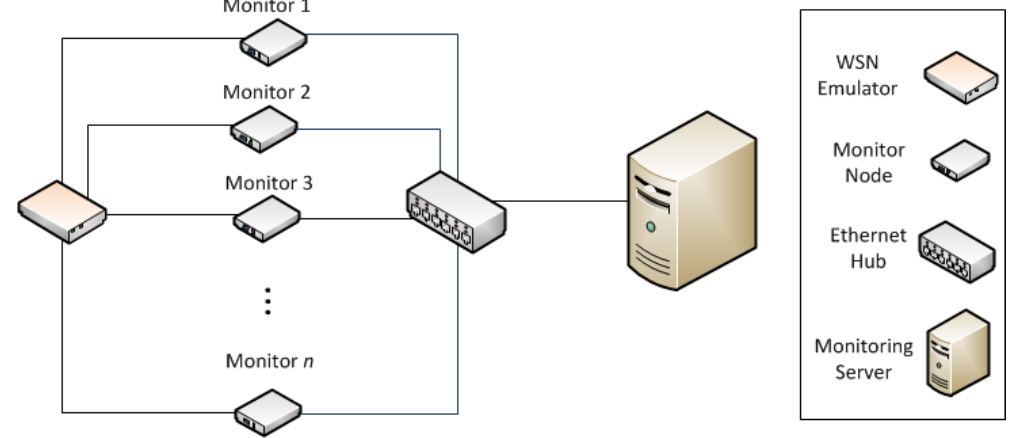
Figure 7. Architecture and elements of the experiment.